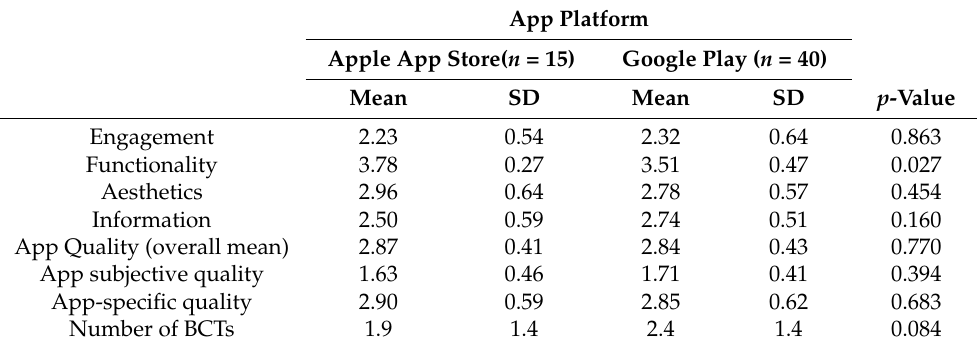
Table 2. App quality and behaviour change technique assessment scores according to app